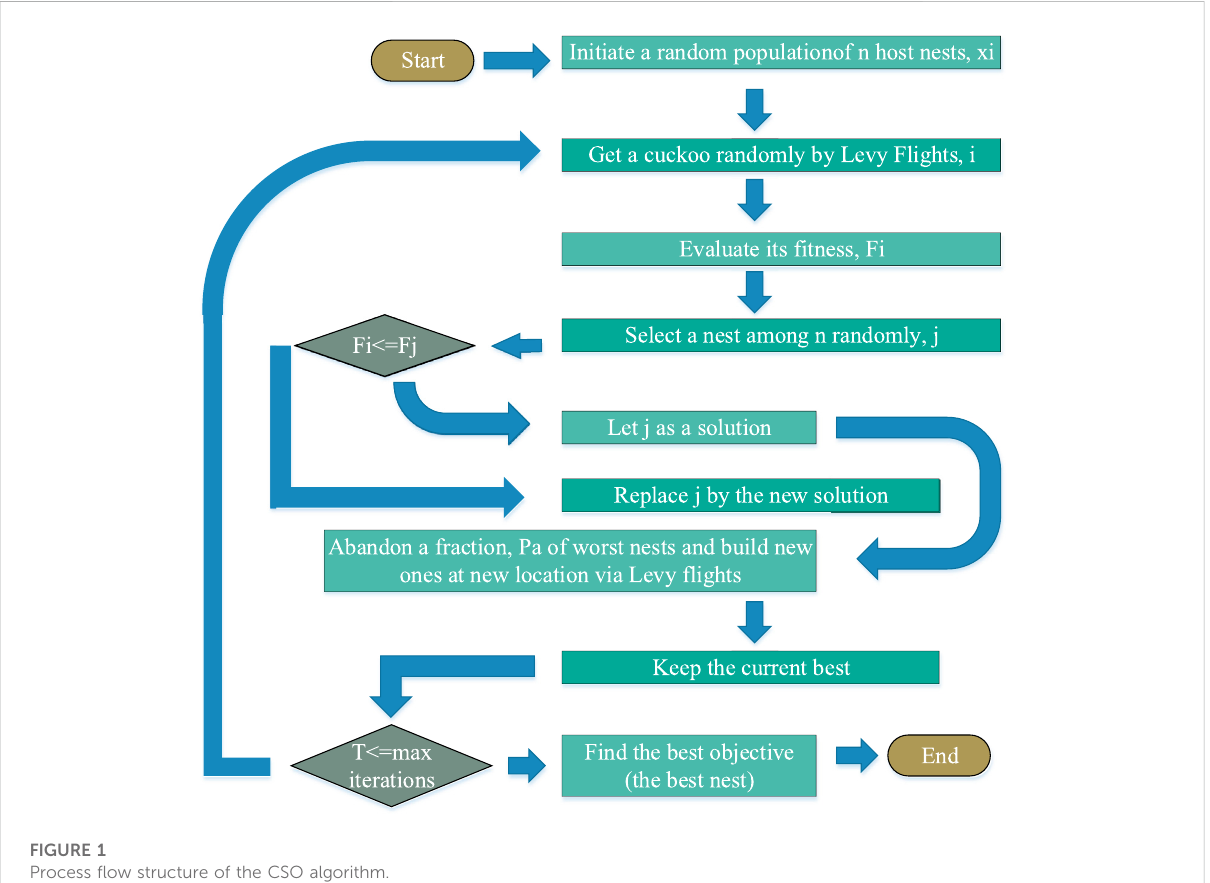
FIGURE 1 Process fl ow structure of the CSO